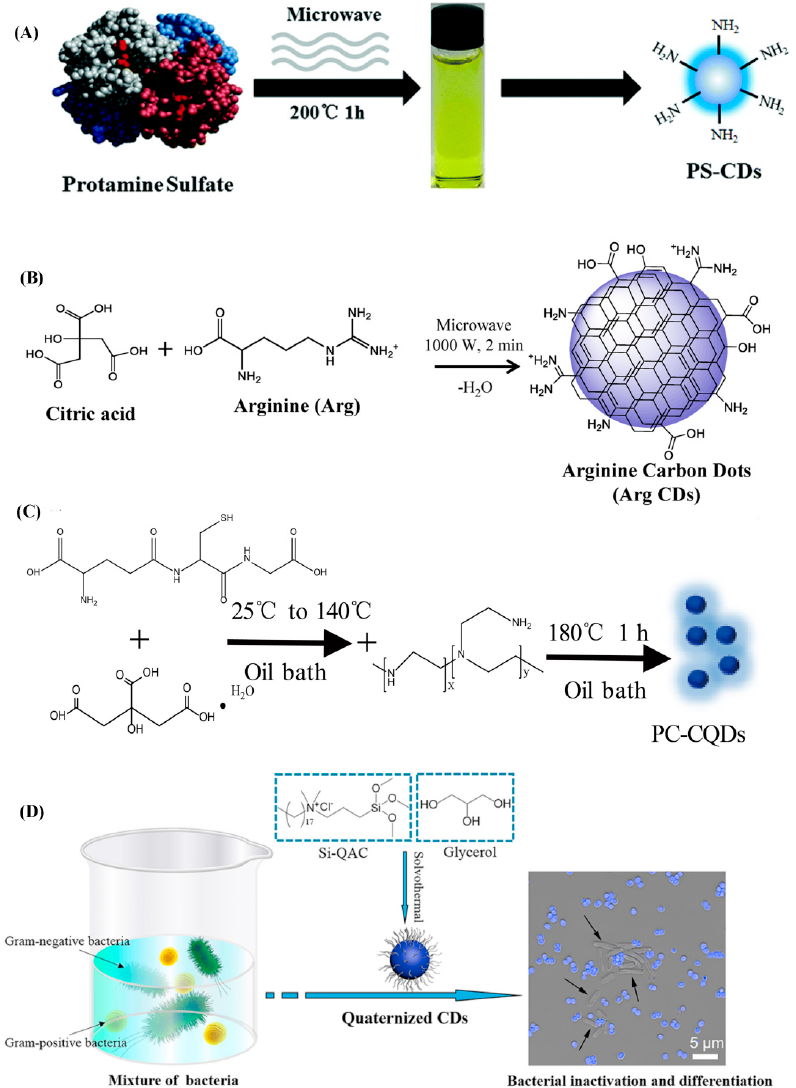
Figure 2. Schematic diagram showing the preparation of nitrogen-doped CDs with antimicrobial activities from ( A ) protamine sulfate (PS), ( B ) arginine, ( C ) L-glutathione, and ( D ) Si-QAC. ( A ) Repro- duced with permission from [40]. Copyright 2021, The Royal Society of Chemistry. (B) Reproduced with permission from [41]. Copyright 2020, MDPI. ( C ) Reproduced with permission from [46]. Copy- right 2021, Elsevier B.V. ( D ) Reproduced with permission from [48]. Copyright 2019, Elsevier